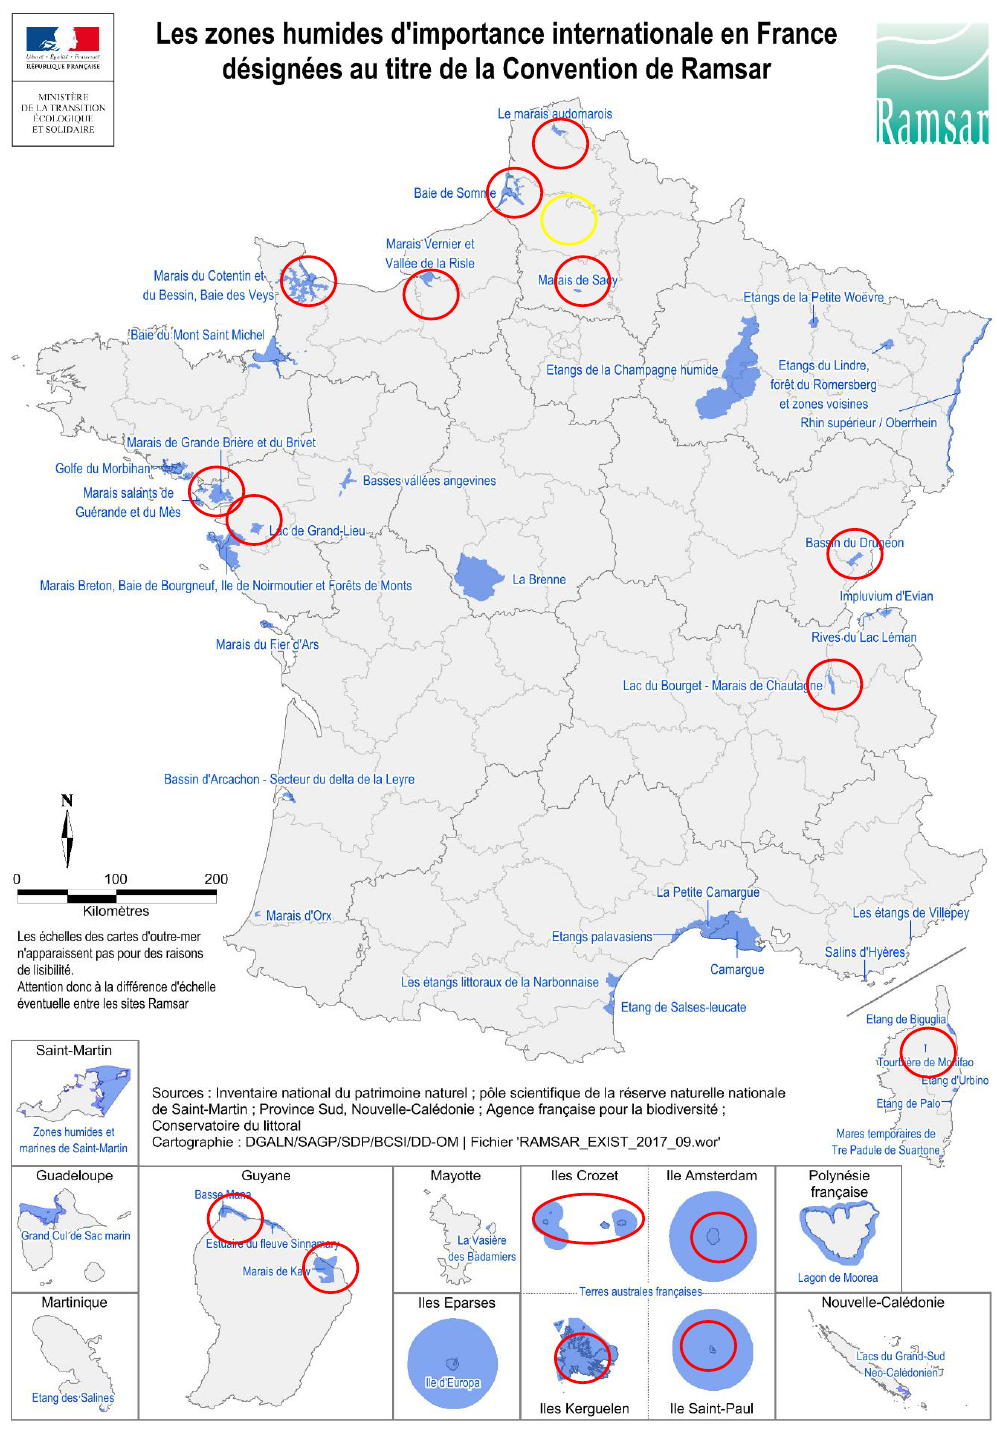
Figure 2. Translation of the title: French Wetlands of international significance designated according to the Ramsar Convention. Sites indicated by red circles ( ) have significant areas of mire, and are listed